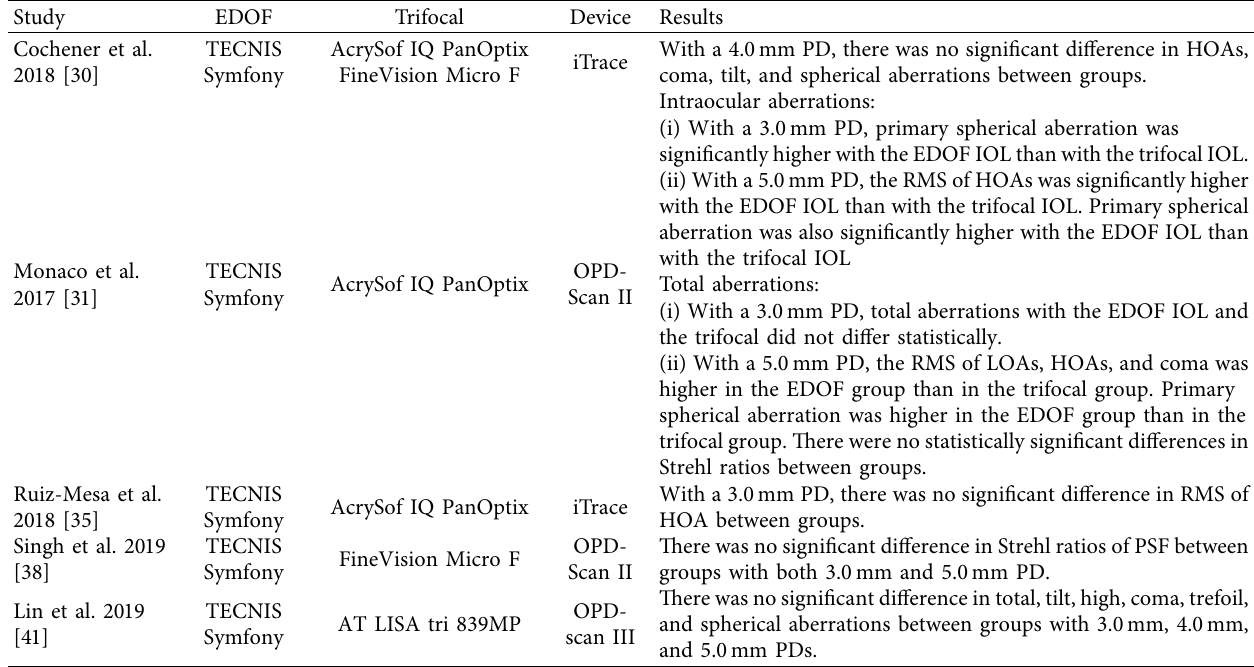
Table 3: Summary of